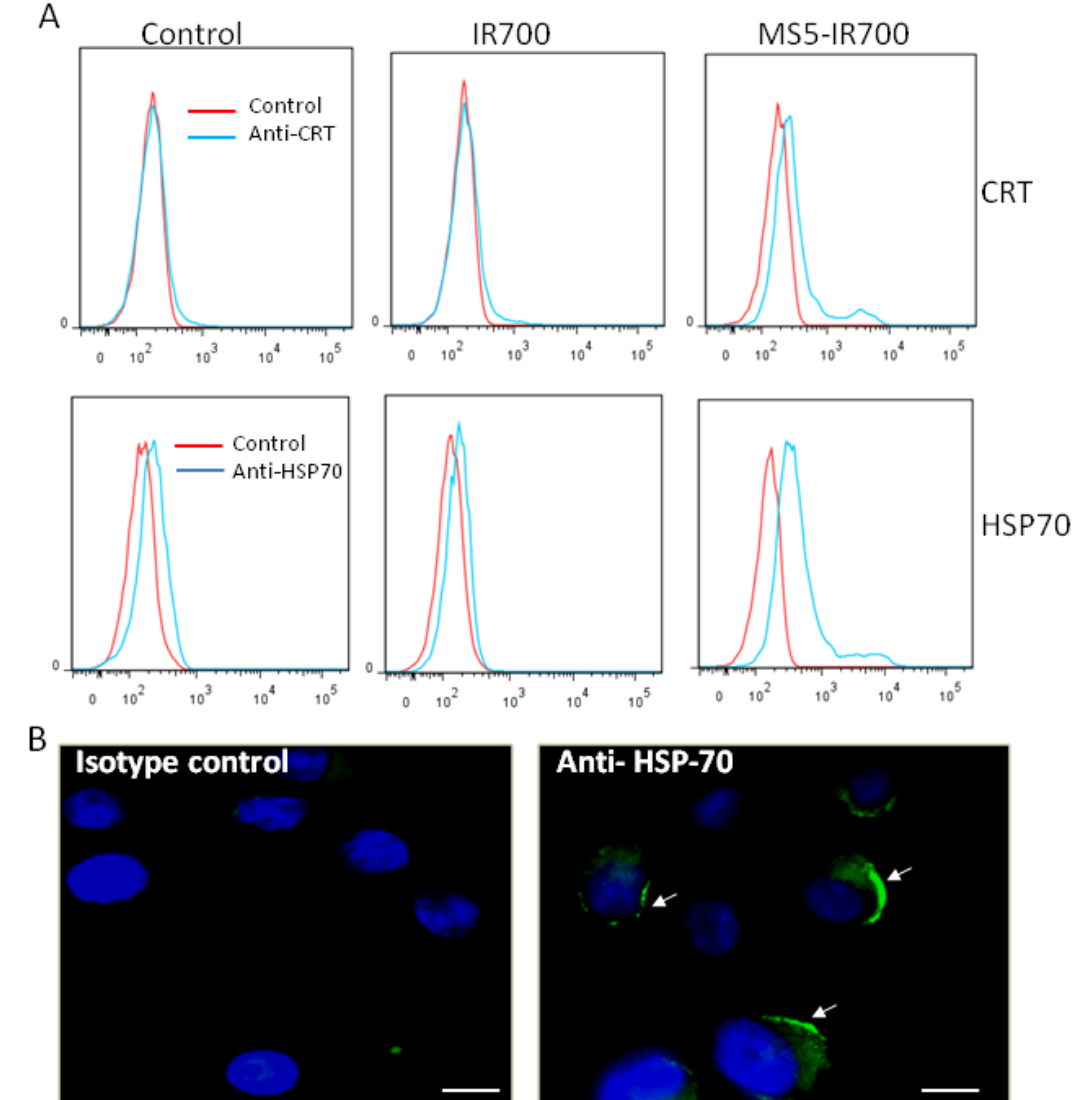
Figure 9. Surface display of heat shock protein 70 (HSP70) and calreticulin (CRT) after NIR light exposure. Experimental conditions are as in Figure 2. ( A ) Seven hours post-NIR irradiation, the expression of HSP70 and CRT on PC3 cells was investigated by flow cytometry using specific antibodies. The data are representative of 3 independent experiments. ( B ) Eight hours post-NIR light irradiation, the MS5-IR700-treated cells were stained with an anti-HSP70 antibody (green), fixed, and then fluorescence images were taken. The membrane location of HSP70 is indicated by arrows. Nuclei were visualized with Hoechst 33342 staining (blue). Scale bars present 20 μ m.